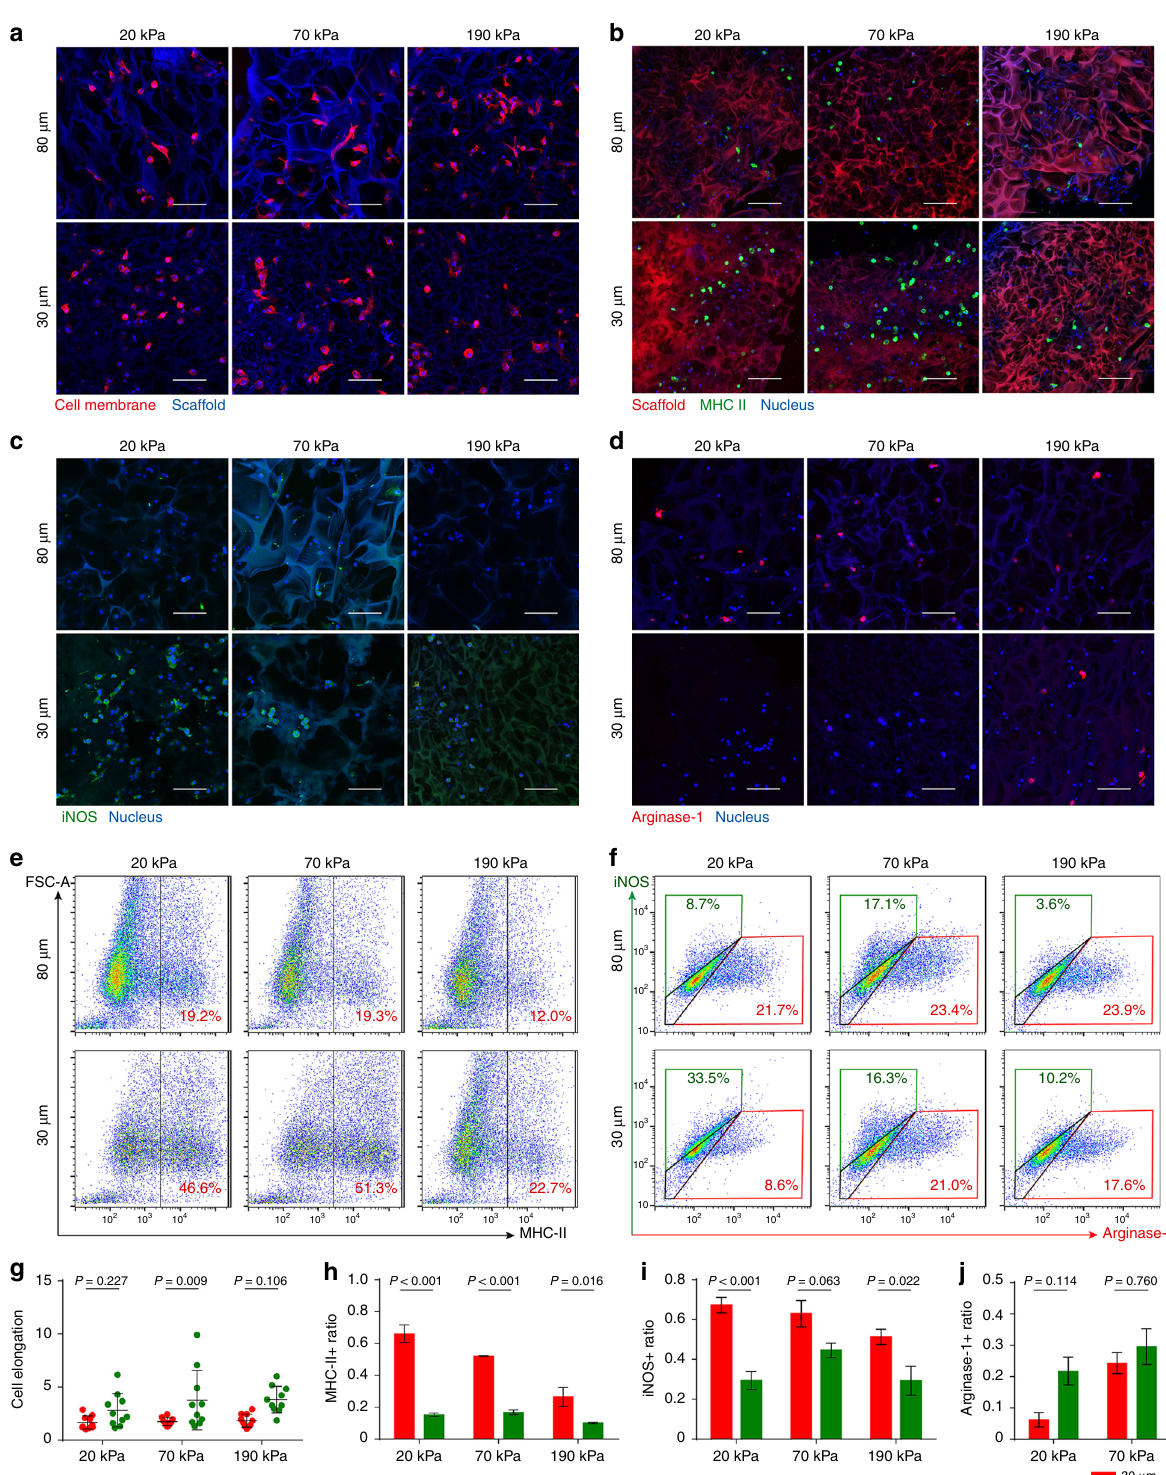
Fig. 4 BMDM phenotypes can be modulated by pore size and stiffness of the scaffolds. a , b Fluorescent images of BMDMs stained for plasma membrane (red) and MHC-II (green) in auto- fl uorescent gelatin 3D porous scaffolds. c , d Fluorescent images of BMDMs stained for iNOS (M1, green) and Arginase-1 (M2, red) in auto- fl uorescent gelatin 3D porous scaffolds. e Flow cytometry analysis of MHC-II-positive cells in scaffolds with different pore sizes and stiffness. f Flow cytometry analysis of iNOS/Arginase-1-positive cells in scaffolds with different pore sizes and stiffness. g – j Quanti fi cation of cell elongation ( n = 10), the ratio of MHC-II-positive cells ( n = 3), iNOS-positive cells ( n = 4) and Arginase-1-positve cells ( n ≥ 3) in scaffolds with different pore sizes and stiffness in fl uorescent images. Scale bar: 50 μ m. Data are means ± s.e.m.